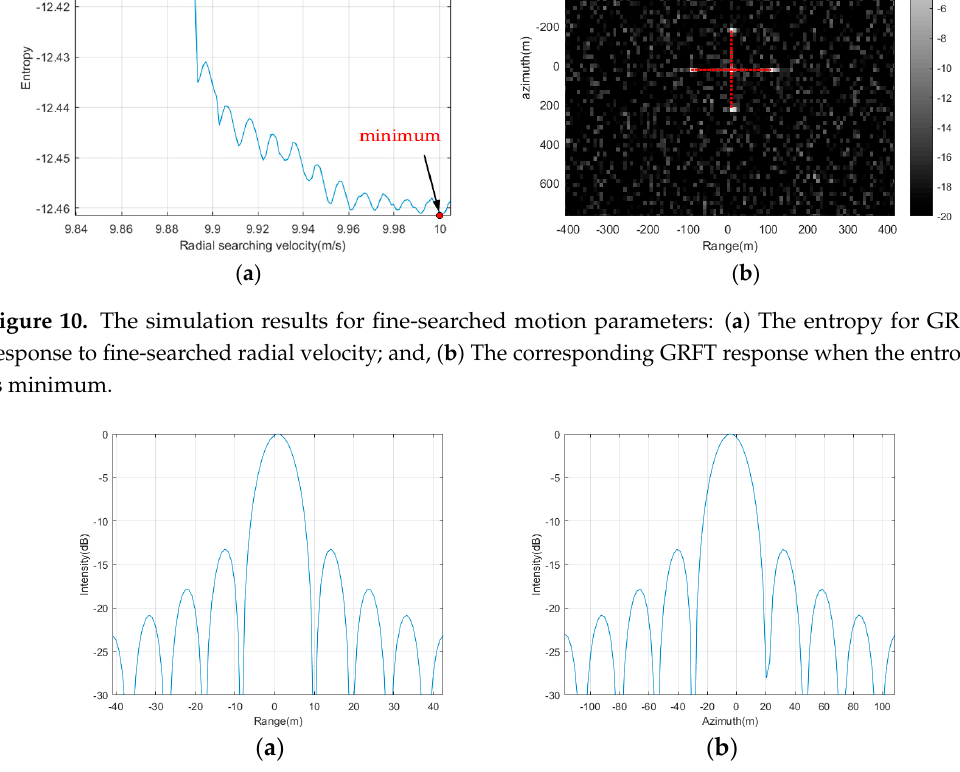
Figure 11. Range profile and azimuth profile of GRFT-based point target imaging: ( a ) the range profile; and, ( b ) the azimuth profile.